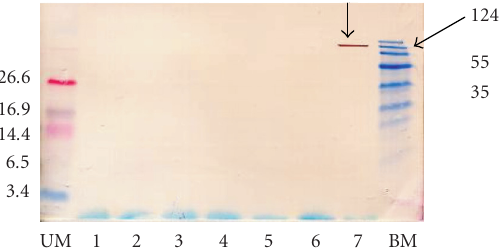
UM BM1 2 Figure 4. Western blot (using the anti-myc-antibody) for time- course samples of induced transformed Pichia pastoris X-33 cells. UB represents ultra-low marker (peptides). BM represents broad-range marker (proteins). 1–6: P pastoris X-33 time-course induced samples. 7: P pastoris LacZ expression control (48